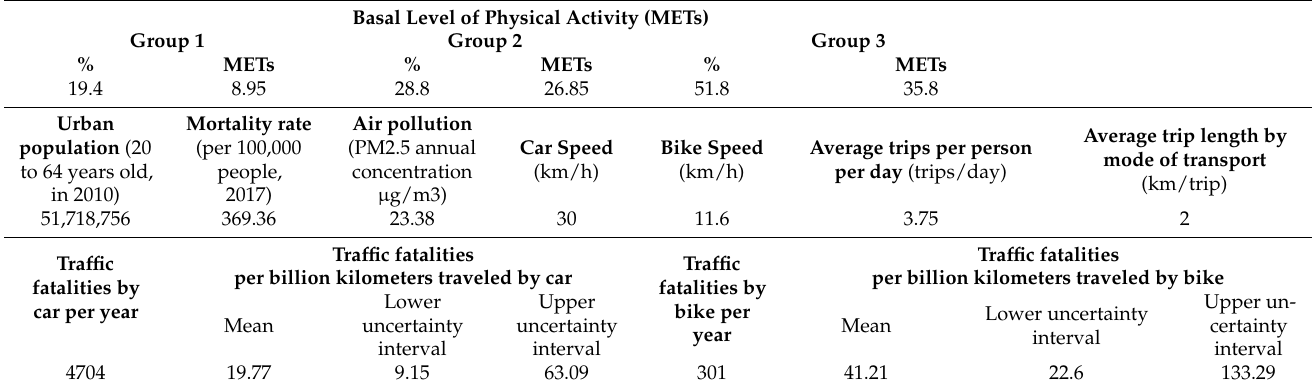
Table 1. Input data used in the